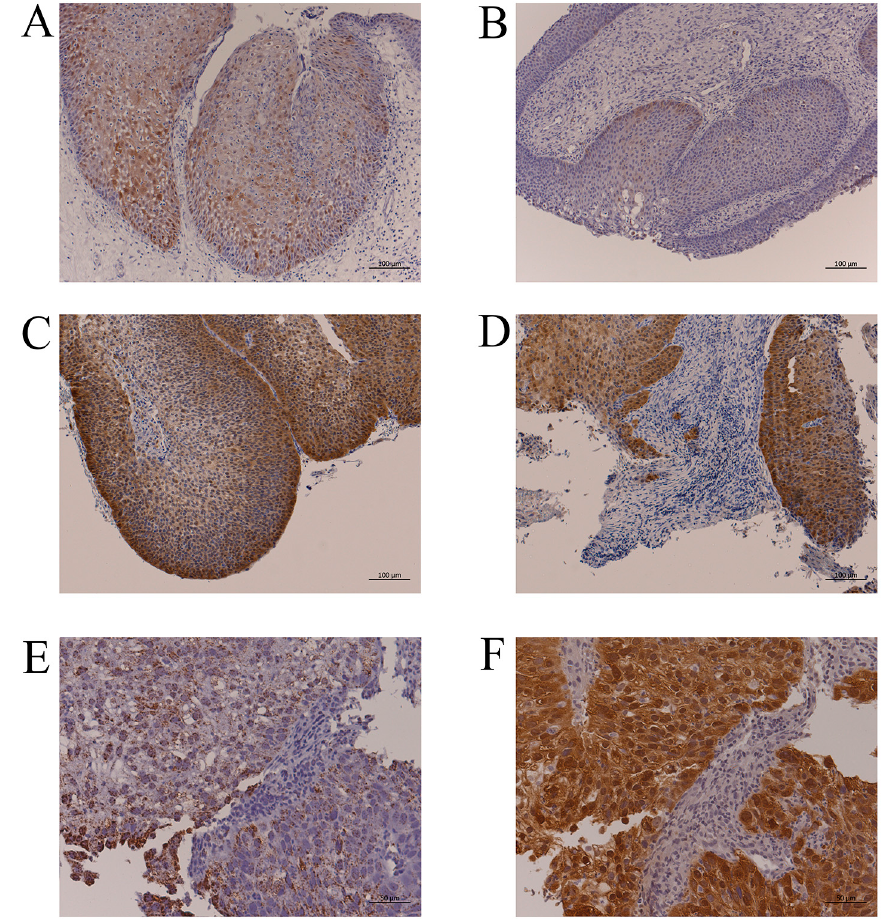
Figure 1. Representative p16 immunohistochemistry and HPV-DNA ISH. ( A ): IP without HPV in- fection (IP-2, Table 2). More than 75% of IP cells had p16 immunoreactivity, but the staining intensity was weak. Bar, 100 µm. ( B ): IP with HPV-16 DNA by PCR (IP-5, Table 2). There were few p16- positive cells despite HPV infection. Bar, 100 µm. ( C ): p16 overexpression in the IP part of IP-SCC with HPV-18 infection (IP-SCC-3, Table 2). Bar, 100 µm. ( D ): p16 overexpression in the SCC part of IP-SCC with HPV-18 infection (IP-SCC-3, Table 2). Strong p16 immunoreactivity was observed in SCC and IP. Bar, 100 µm. ( E ): HPV-DNA ISH of SNSCC with HR-HPV infection (SNSCC-5, Table 2). A positive reaction was observed in all cancer cells. Bar, 50 µm. ( F ): p16 overexpression in SNSCC with HR-HPV infection (SNSCC-5). Cancer cells showed strong p16 immunoreactivity. Bar, 50 µm. 3.2.2. HPV Infection in IP-SCC Of the seven patients with IP-SCC, four (57.1%) had HPV DNA: three with HR-HPV (HPV-16, -18, and -33) and one with low-risk HPV (HPV-11). The viral load of IP-SCC-1 (HPV-16) was low (Table 2), and p16 overexpression was not observed in this case. In the IP-SCC group, there were two cases with p16 overexpression (28.5%) who also had HR- HPV DNA by PCR and/or ISH. The HPV-18-positive case (IP-SCC-3) had a viral load of 2.63 × 10 3 copies/ng DNA and an E2/E6 ratio of 8.0 × 10 − 4 . In addition, p16 expression was moderate in the IP area (Figure 1C), whereas it was strong in the SCC area (Figure 1D). Thus, two IP-SCC patients (28.5%) were considered to have HPV-related tumors. 3.2.3. HPV Infection in SNSCC Of the 20 patients with SNSCC, 7 (35%) had HR-HPV DNA (Table 2). Although HPV- 16 was detected in SNSCC-7 and -8, their viral loads were relatively low, and they did not overexpress p16. The remaining fi ve HR-HPV-positive cases (SNSCC-2 to -6) also had p16